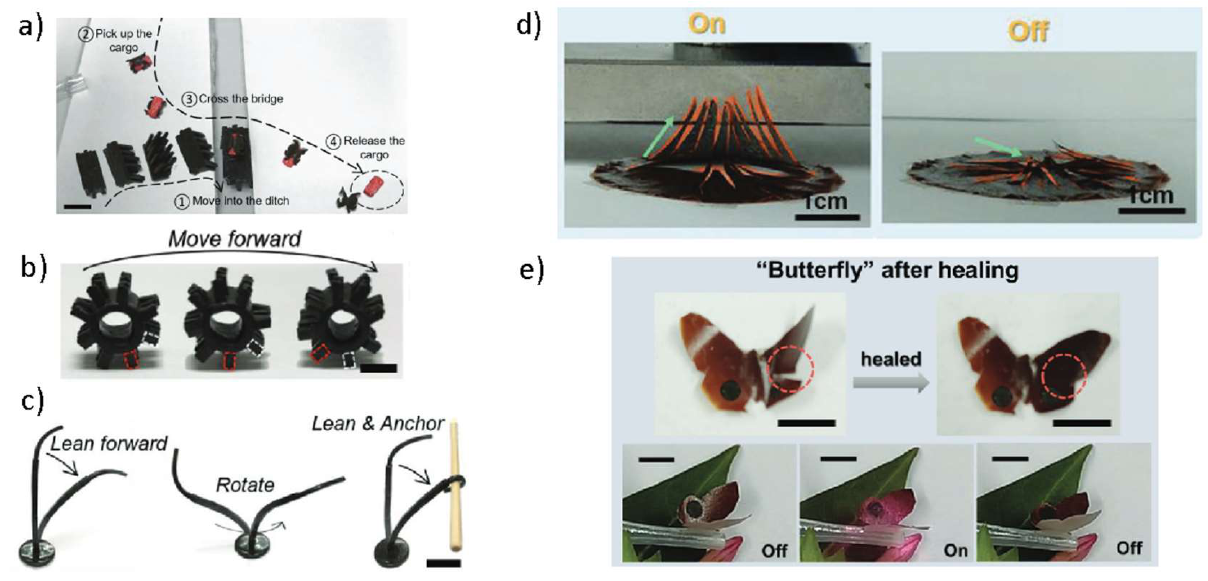
Figure 6. ( a ) A cargo transport task accomplished by a soft self-healing actuator under the presence of external magnetic fields; ( b ) a multiterrain carrier able to move forward using magnetic leg tilts; ( c ) magnetically controlled artificial soft tendrils. Adapted with permission from [86] .